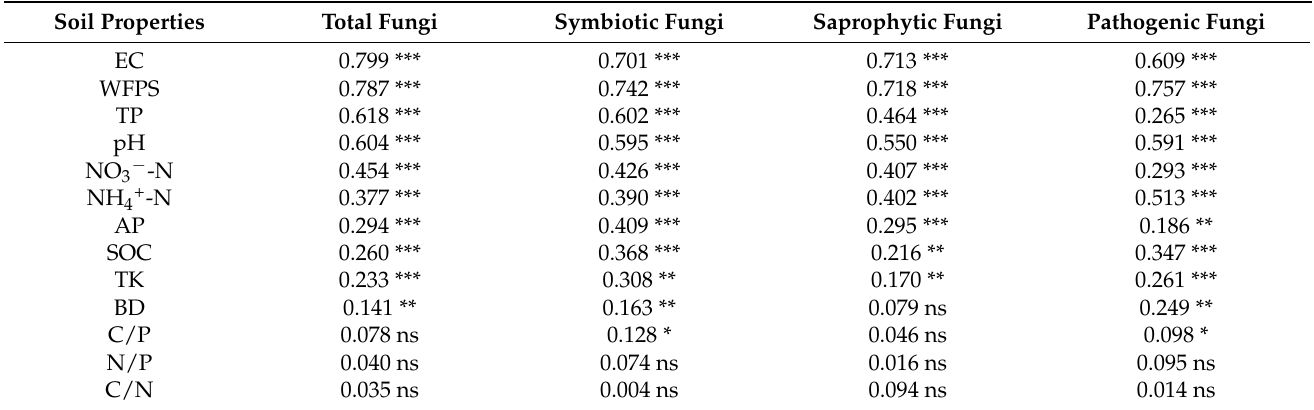
Results of Monte Carlo permutation tests for soil properties and soil fungal community composition.